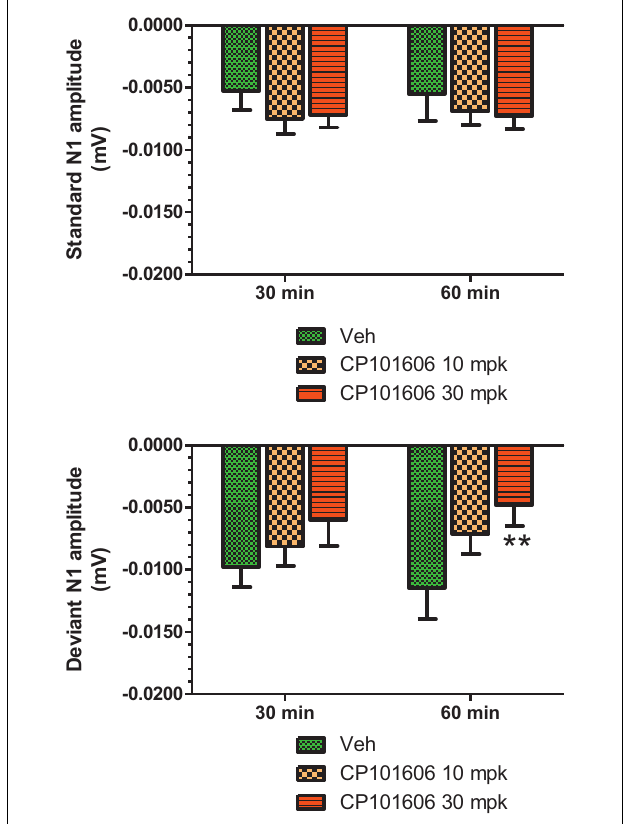
FIGURE 9 | Standard and deviant N1 ERP amplitudes after vehicle or CP-101,606 (10 or 30mg/kg) treatment are shown .Top panel shows standard N1 amplitudes and bottom panel shows deviant N1 amplitudes. Notice that only deviants after CP101,606 show apparent dose-dependent reduction in N1 amplitude. **Indicates P < 0.01 (Bonferroni’s